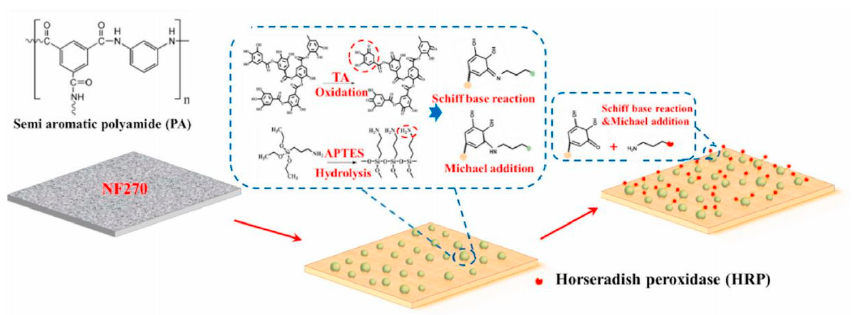
Figure 3. Schematic illustration of TA-APTES coating and HRP immobilization on an NF membrane. Reproduced with permission from Reference [110]. Copyright 2021, Elsevier.